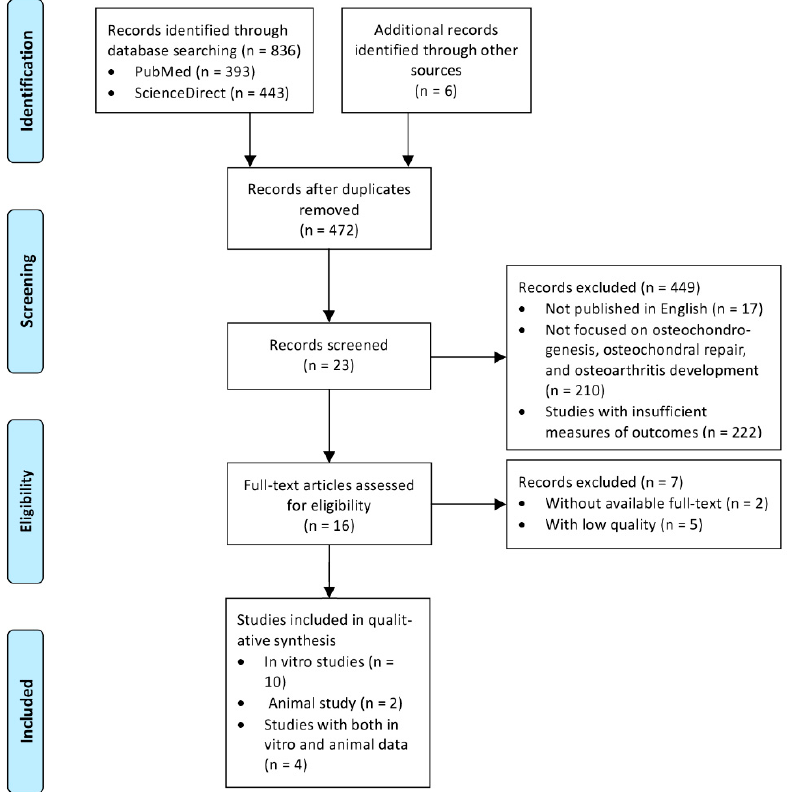
Figure 1. Study selection progress according to the Preferred Reporting Items for Systematic Reviews and Meta-Analyses guidelines [30] .